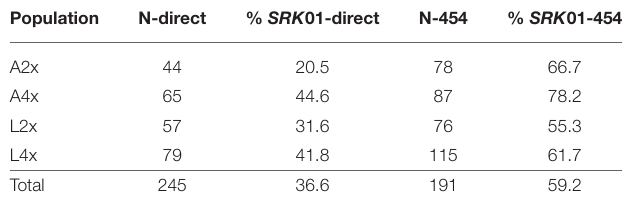
TABLE 2 | Distribution of alleles (A) and haplotypes (B) across diploid (A2x, L2x) and tetraploid (A4x, L4x) populations (POP) for different predicted dominance classes (A2 and A3 are dominant to B), excluding Class A1, which is represented only by SRK 01; read numbers were too low to be certain about presence or absence for that allele.